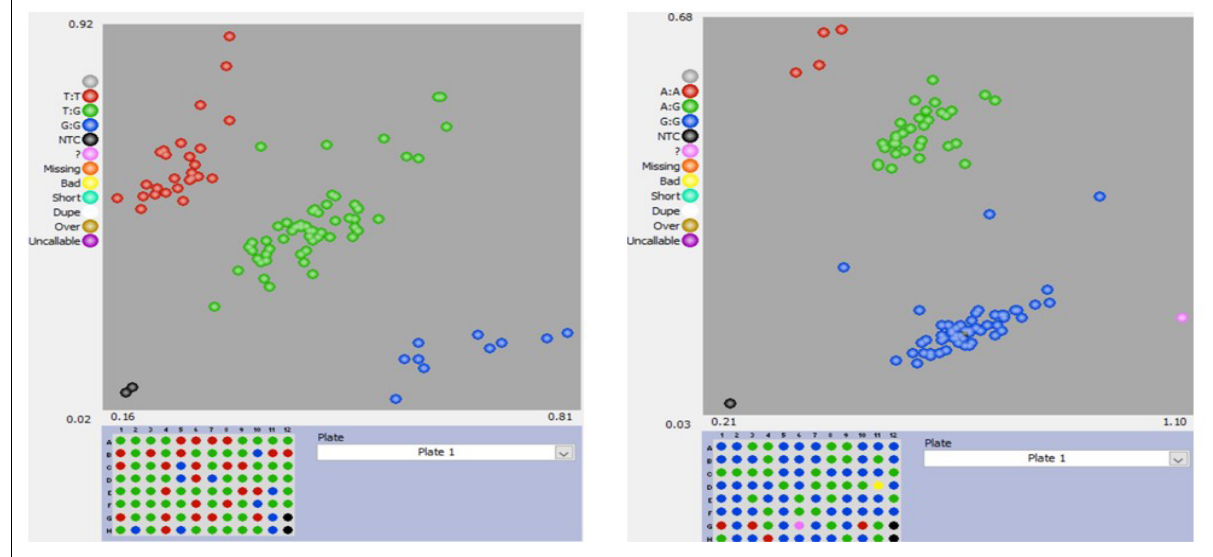
Red spots = homozygote resistant genotypes; green spots = heterozygotes; and blue spots = homozygote susceptible genotypes Figure 3: Polymorphism patterns of the two single nucleotide polymorphism markers after Kompetitive allele-specific PCR genotyping assays.